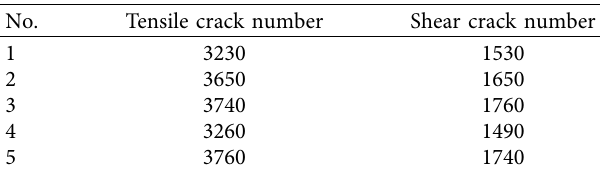
Figure 11: The number of the crack accumulation with various cleat Table 7: Statistics of the crack number with different face cleat spacing.